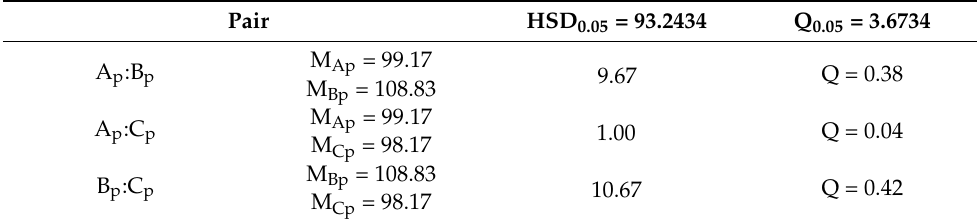
Table 20. Pairwise comparisons of producing semi-finished furniture elements with Tukey